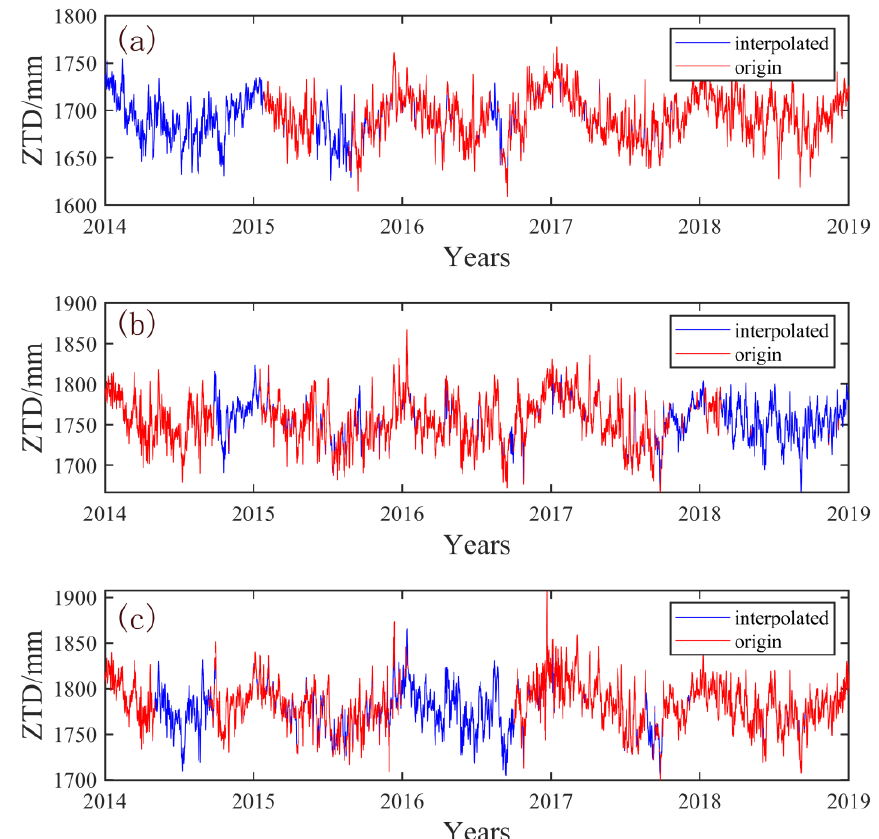
Figure 4. Zenith tropospheric delay (ZTD) time series before and after interpolation at the ( a ) HOG2, ( b ) KHLR, and ( c ) WAI2 stations, with missing rates of 29.5%, 30%, and 28.6%, respectively.